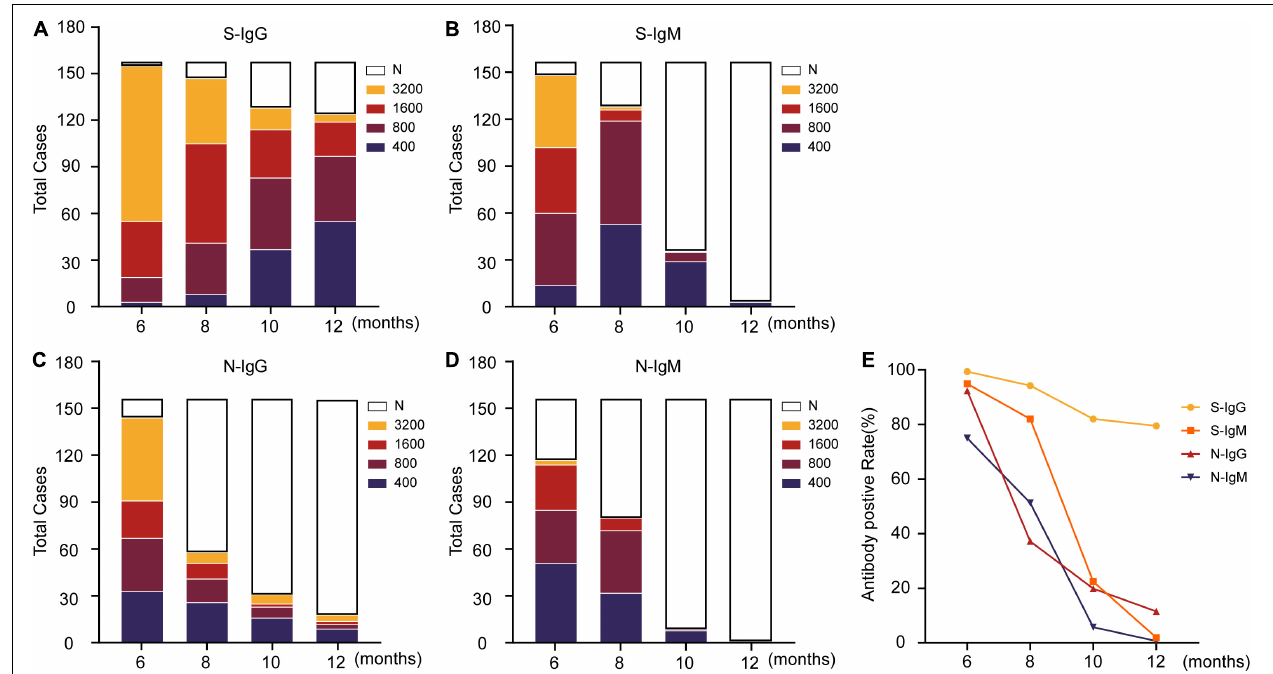
FIGURE 2 | Changing trend of the titers of IgG, IgM and neutralizing antibodies against SARS-CoV-2 S/N in patients. (A–D) Indicates the change in antibody titers at different time points, where N indicates that the titers have dropped below the ELISA cutoff and cannot be detected. (E) Displays the changing trend of the antibody-positive rate. The data are shown as the mean ± SEM, and the significance is expressed as ns, P >